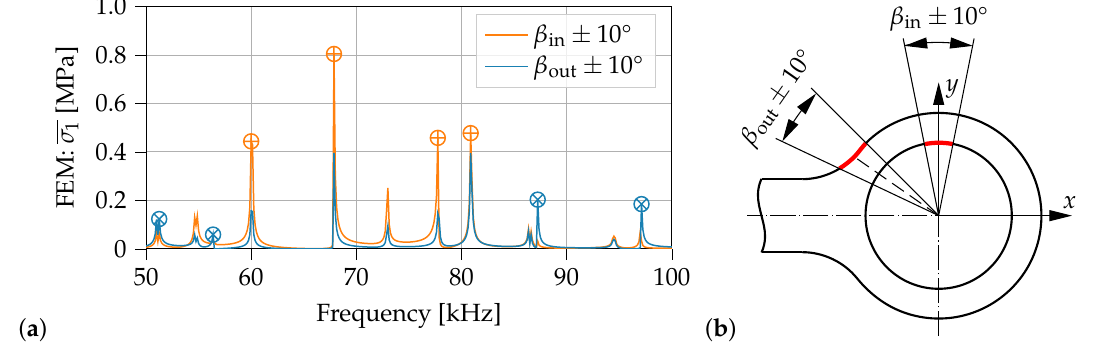
Figure 8. Identification of sensitive resonance frequencies: ( a ) Mean stress spectra σ 1 of pristine necked lug, ( b ) FEM stress results σ 1 in the defined range of 10° around each location of possible crack initiation are used to calculate the mean values ± of major principal stresses σ 1